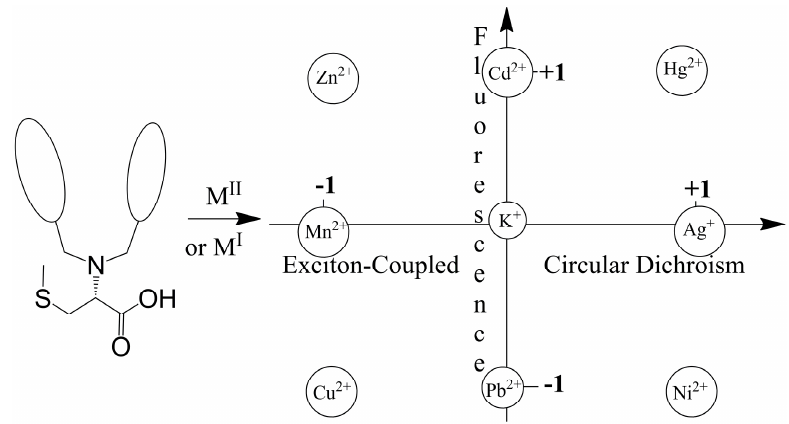
Figure 23. Chiroptically enhanced fluorescence detection and differentiation of different metal ions by L -CysBQA through pattern recognition. Adapted with permission from Reference [61]. Copyright (2011) Wiley.